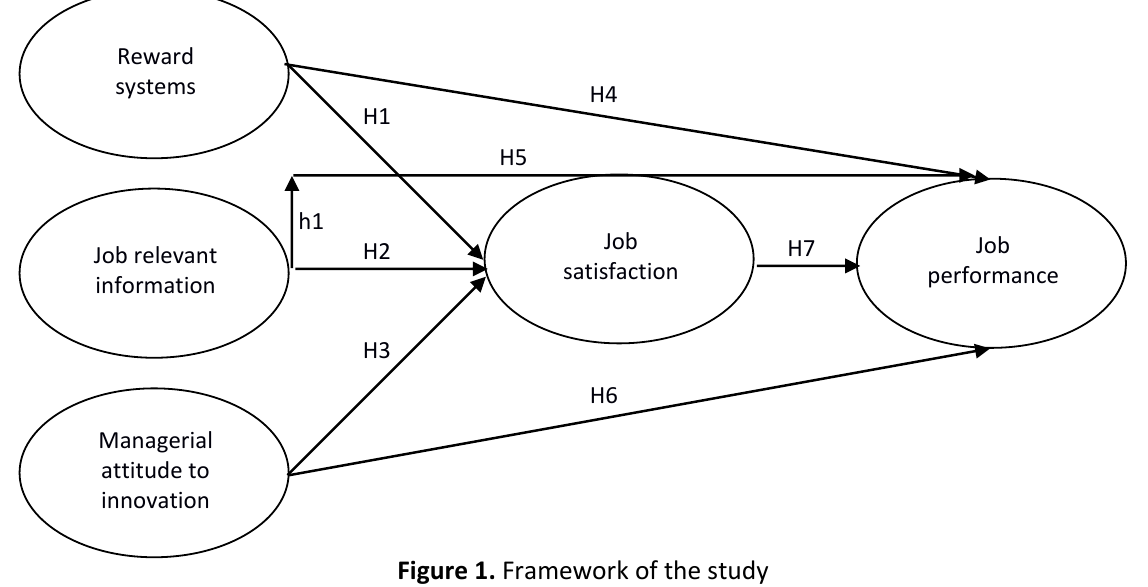
Figure 1. Framework of the